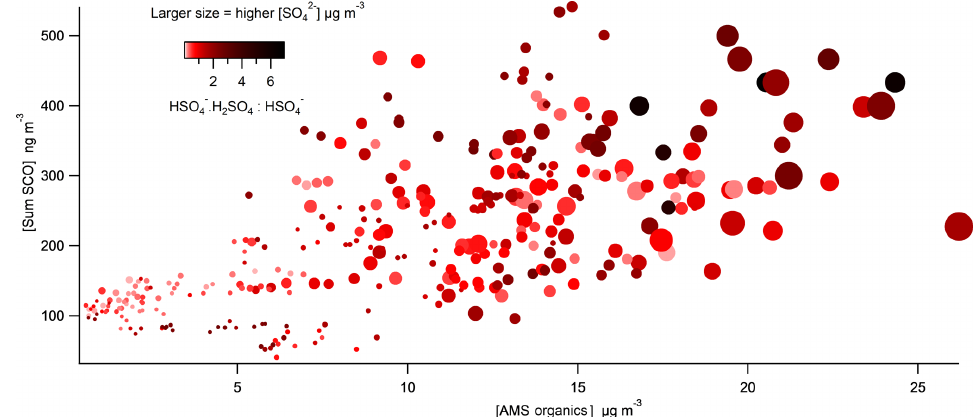
· H 2 SO 4 :HSO 4 are colour coded) 4